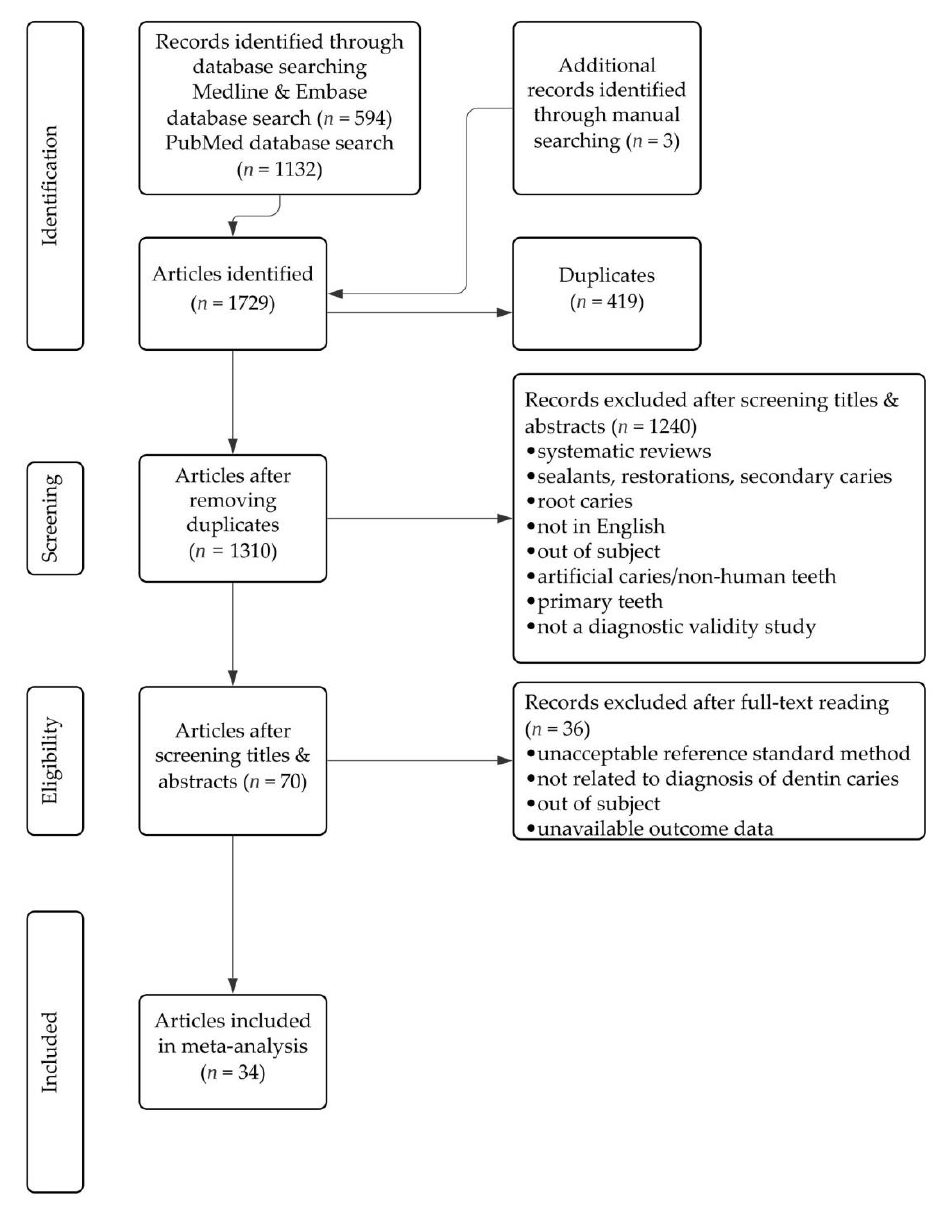
Figure 1. Flow diagram of the study selection process.